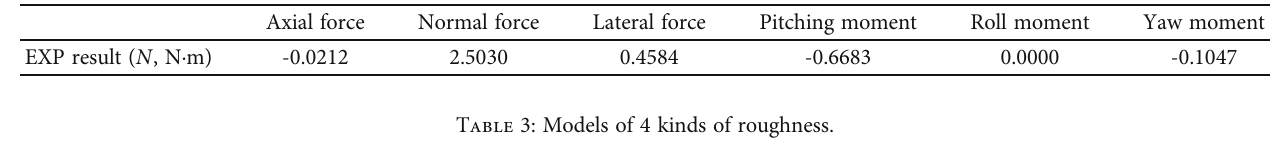
Table 2: Average aerodynamic force.